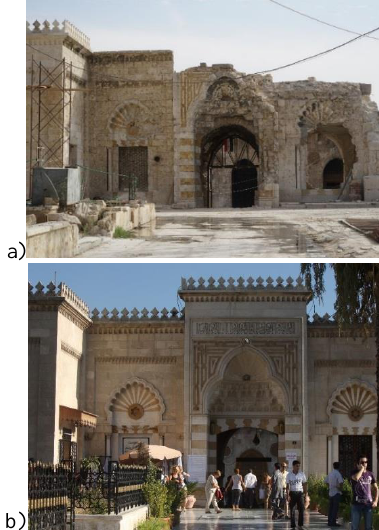
Figure 9. The el Haways Madrasa interior, current situation (a) and how it was in 2010 (b).